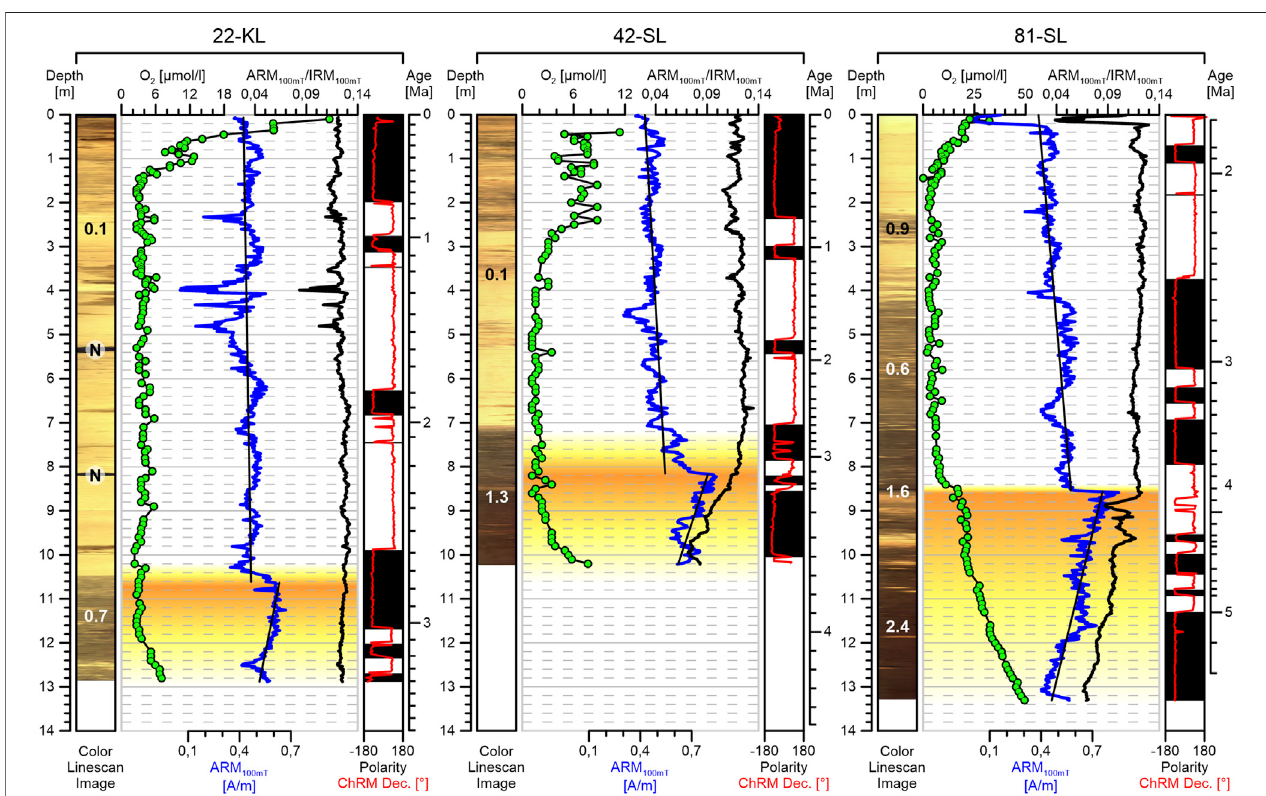
FIGURE 8 | Depth plots of geochemical and rock magnetic parameter records from our three cores. Ex-situ oxygen measurements (green markers) for cores 22- KL and 81-SL are from Kuhn et al. (2017), Versteegh et al. (2021). The oxygen record of core 42-SL is from Versteegh et al. (2021). The bow shaped oxygen concentrations indicate upward directedoxygendiffusionalong thesediment-crust interface and intermediate-depth oxygendepletionwithinthe sediment column at all three sites. The ARM 100mT record shows a pronounced increase in fi ne magnetite content at the lower oxygen boundaries. The grain size sensitive ARM 100mT / IRM 100mT ratio suggests a downward coarsening of magnetic grain size in the lower oxygenated zones at sites 42-SL and 81-SL. Calibrated linescan images are displayedattheleftofeachcore.Thenumbersalongthecoreimagesindicatethesolidphasemanganesecontents(inwt%)inthecorrespondingsectionsofthecoresas well as the location of buried manganese nodules (marked with an encircled N) after Kuhn et al. (2015). ChRM polarity and declination at right show regular (black and white) and irregular (grey with arrow) patterns.